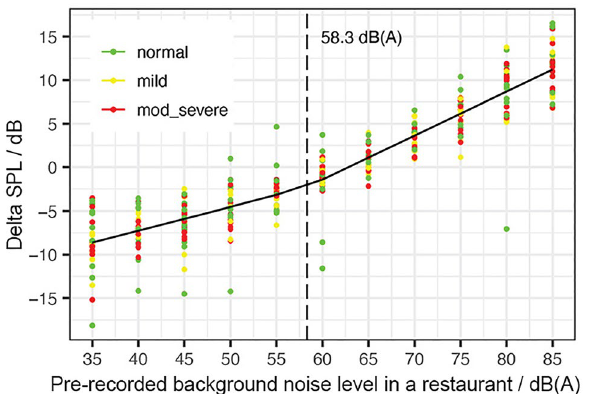
Figure 1. Relationship between the pre-recorded background noise level in a restaurant in dB(A) and Delta SPL in dB. Vertical dashed line marks the